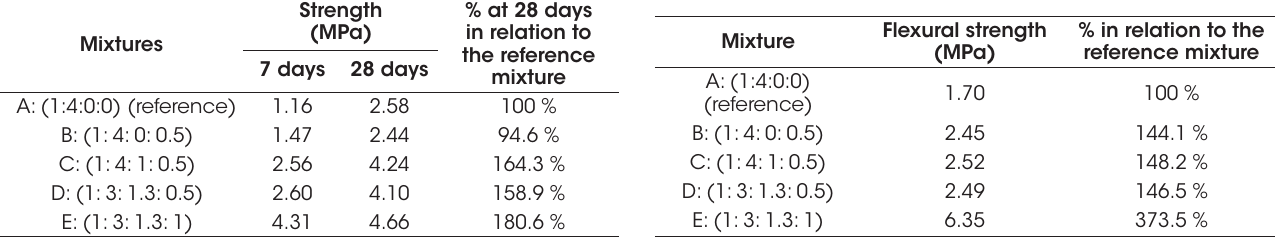
Flexural strength at 28